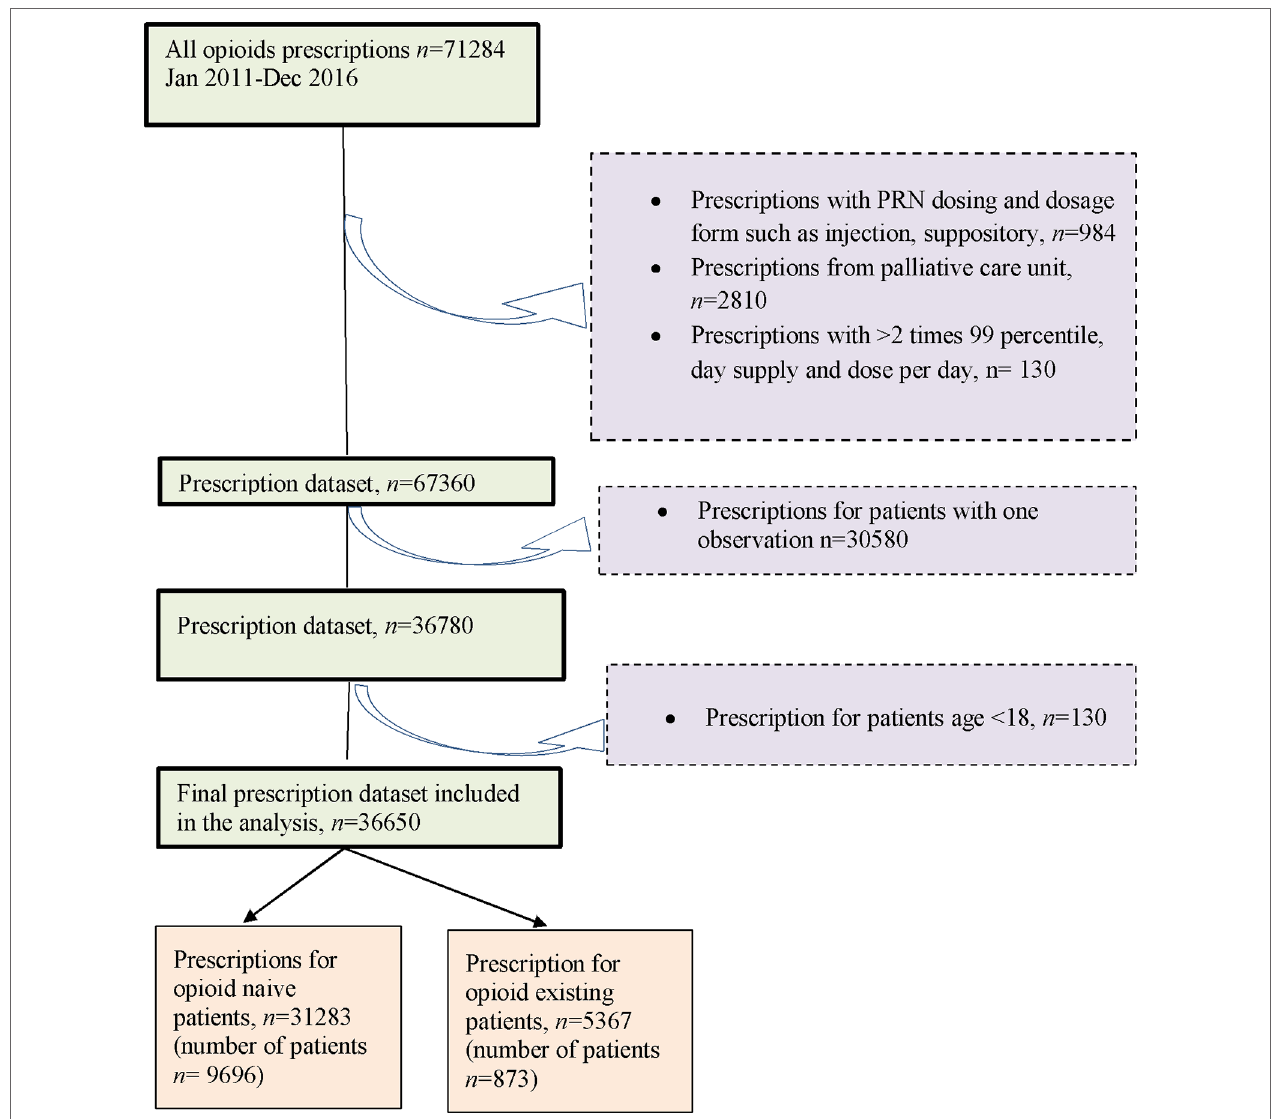
FiGUrE 1 | Cohort flow